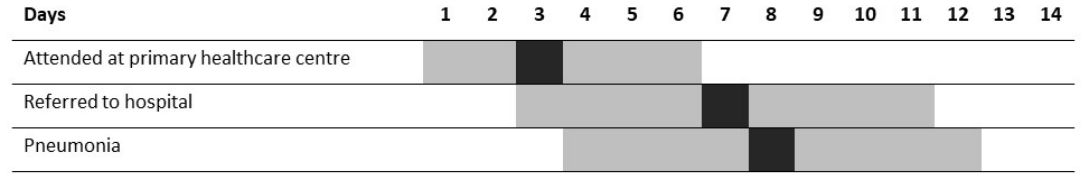
Figure 2. Days elapsed until consultation at primary healthcare center, hospital referral and diagnosis of pneumonia. Mean (dark gray) and standard deviation (light gray).